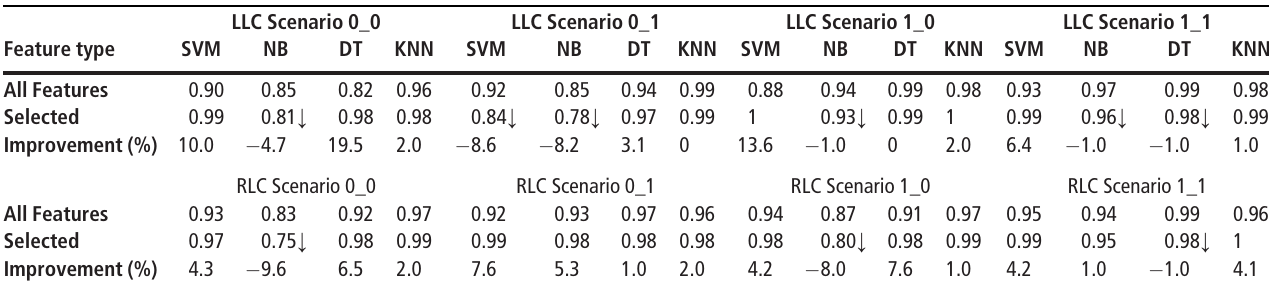
Table V AUC values of comparison results with different models using the selected features and all features in each LC scenario